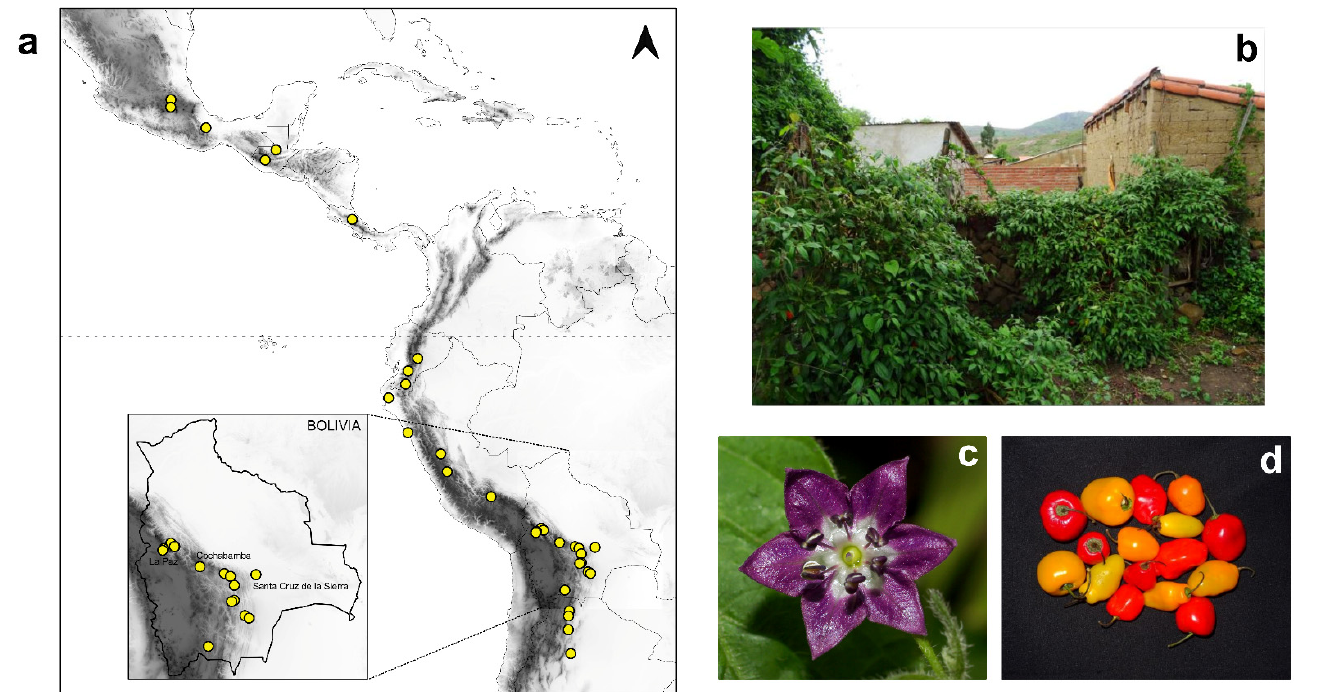
Figure 1. Geographic distribution and featuring of C. pubescens . ( a ) Area of C. pubescens cultivation in South and Central America. Points on the map indicate the location of the studied samples. A detail of the sampling in Bolivia is shown (lower left corner) and major cities are labelled. ( b ) Large shrub growing in family garden in Moro Moro, Bolivia. ( c ) Flower and ( d ) Fruits acquired in street markets in La Paz, Bolivia.